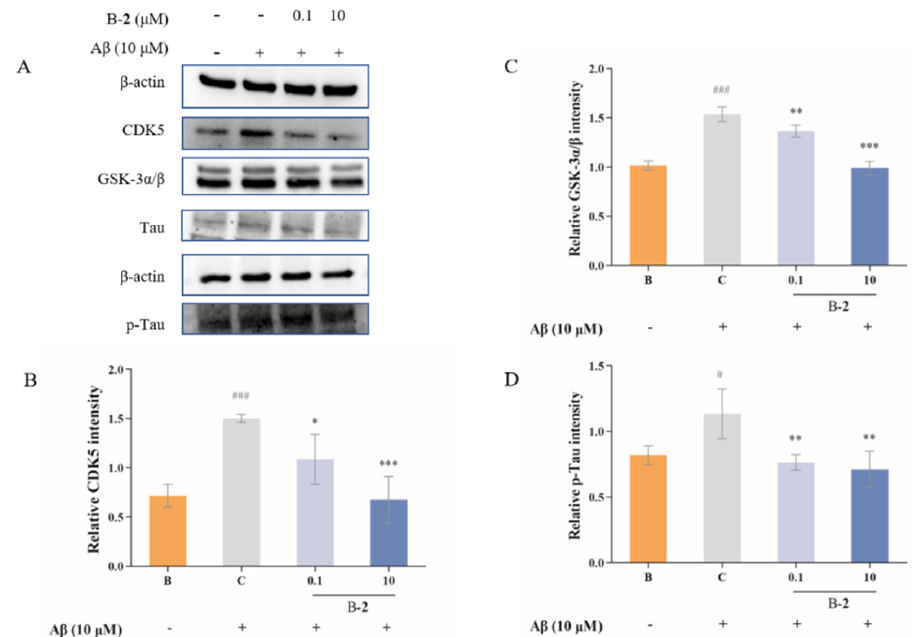
Figure 5. ( A ) Immunoblotting results of CDK5, GSK-3 α / β , Tau and p − Ta. ( B ) CDK5 production of HT-22 cells treated by benzaldehydes 2 . ( C ) GSK-3 α / β production of HT-22 cells treated by benzaldehydes 2 . ( D ) p-Tau production of HT-22 cell treated by benzaldehydes 2 . Cell lysates, antibodies against CDK5, GSK-3 α / β , Tau and p-Tau were used to conduct Western blot analysis.